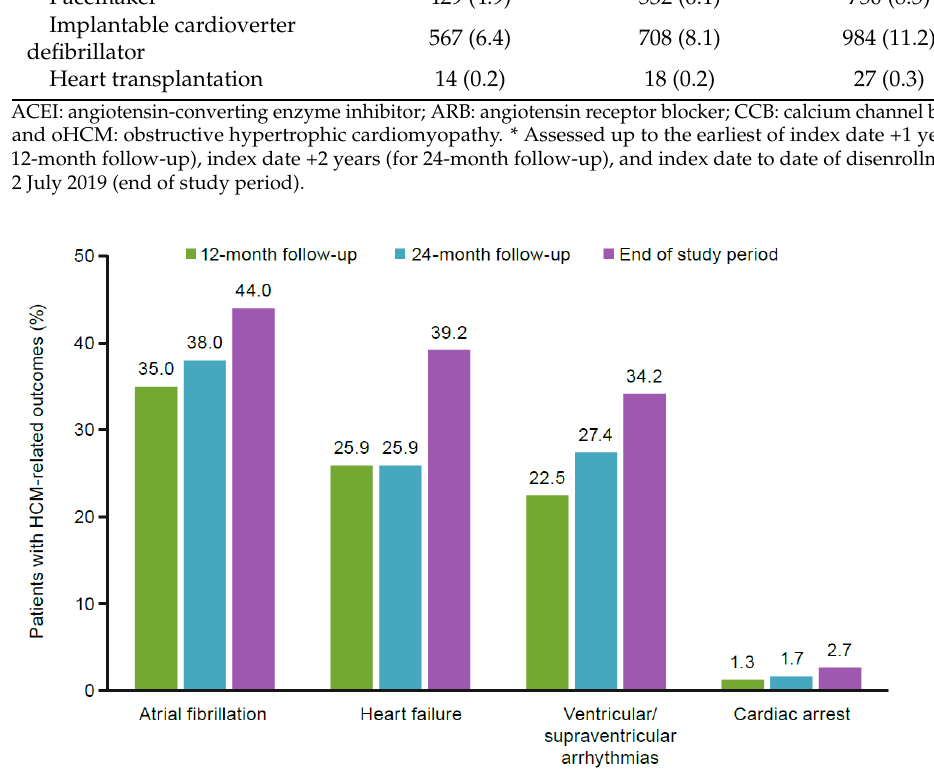
Figure 4. Drug therapy usage before and after septal myectomy or alcohol septal ablation.